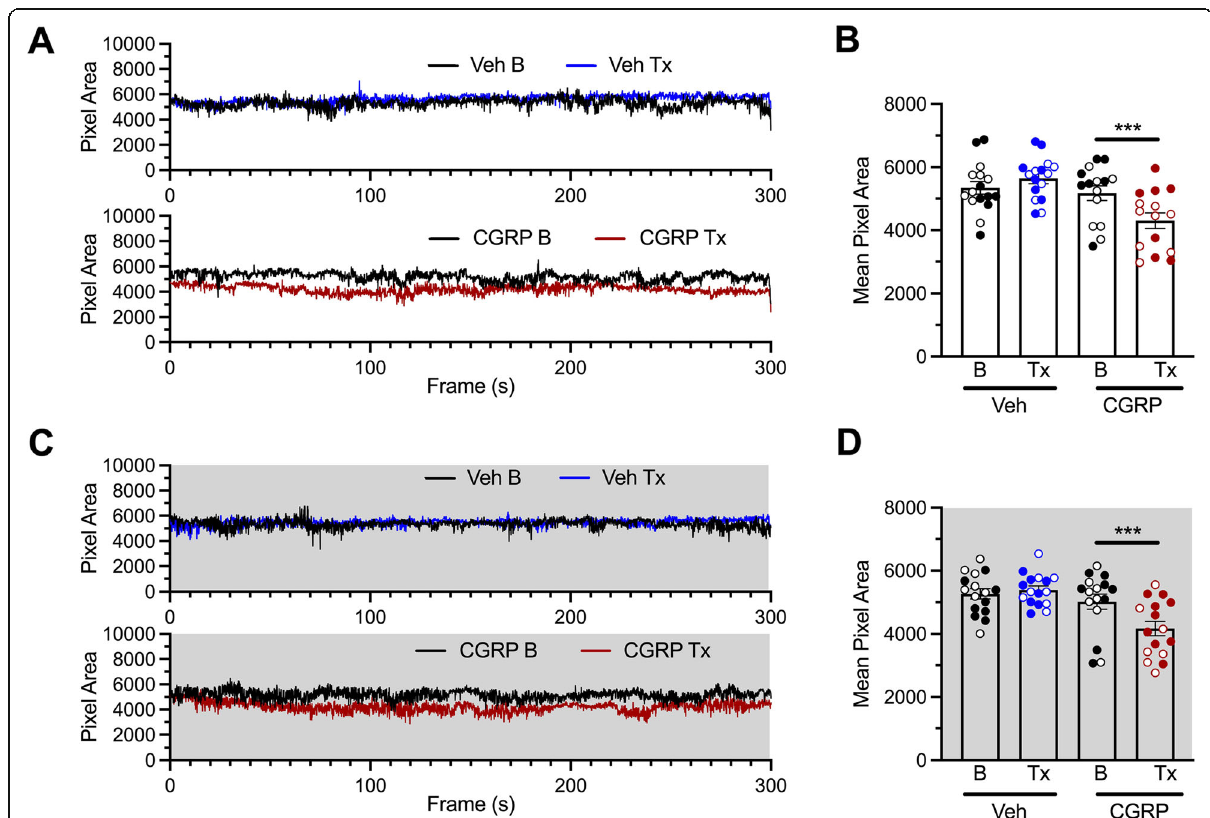
Fig. 6 Peripheral CGRP decreases pixel area of the eye (increases the squint response) during both the active and inactive phases. A Mean pixel area over time during the light phase (10 AM) for each baseline (5 min recording, no injection) and treatment (5 min recording, 30 min post injection) for all mice injected with either Veh (PBS, n = 16, top) or CGRP (0.1 mg/kg, n = 15, bottom). B Mean overall pixel area from panel A ± SEM for all mice during baseline (B) and treatment (Tx) conditions. Empty symbols represent females, and full symbols represent males. There were no statistical differences between males and females. Two-way (factors: time x treatment) ANOVA, Sidak ’ s multiple comparison test *** p < 0.001 compared to corresponding baseline. C Mean pixel area over time during the night phase (10 AM) for each baseline (5 min recording, no injection) and treatment (5 min recording, 30 min post injection) for all mice injected with either Veh (PBS, n = 16, top) or CGRP (0.1 mg/kg, n = 15, bottom). D Mean overall pixel area from panel C ± SEM for all mice during baseline (B) and treatment (Tx) conditions. Empty symbols represent females, and full symbols represent males. There were no statistical differences between males and females. Two-way (factors: time x treatment) ANOVA, Sidak ’ s multiple comparison test *** p < 0.001 compared to corresponding